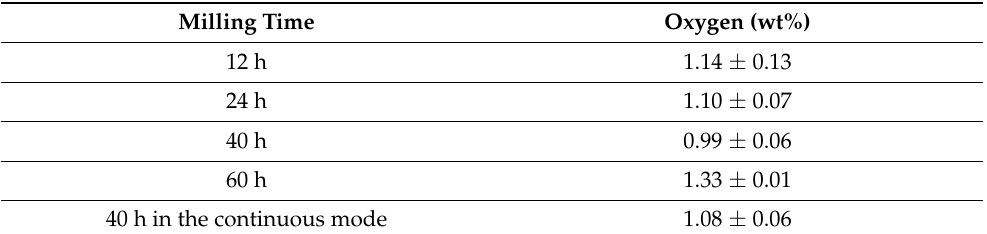
Table 4. Oxygen content obtained during the milling process.